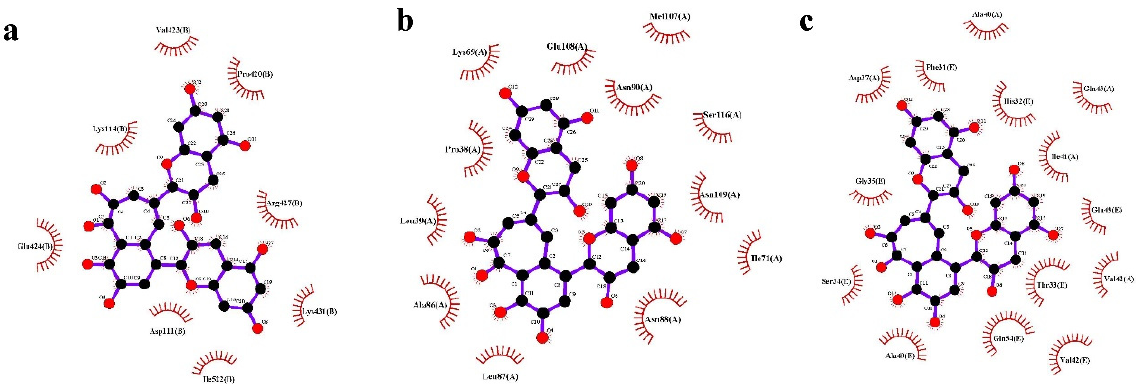
Figure 7. Various interactions and amino acid residues involved in stabilizing protein-TF1 complex. BSA-TF1 complex ( a ), β -lg-TF1 complex ( b ) and α -La-TF1 complex ( c ).